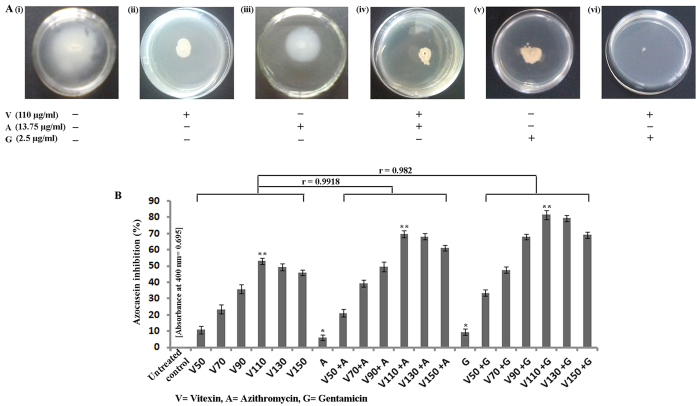
Effect of vitexin, azithromycin and gentamicin on swarming motility of P. aeruginosa (A). Each experiment was performed using three independent cultures; one representative data set is shown here. Percentage increase (with respect to untreated control) in inhibition of azocasein degrading protease release by P. aeruginosa is presented here (B). Each value is the average of triplicate assay where presented data is mean ± SD. Correlation study between experimental sets was done through Pearson’s correlation and expressed by r value.